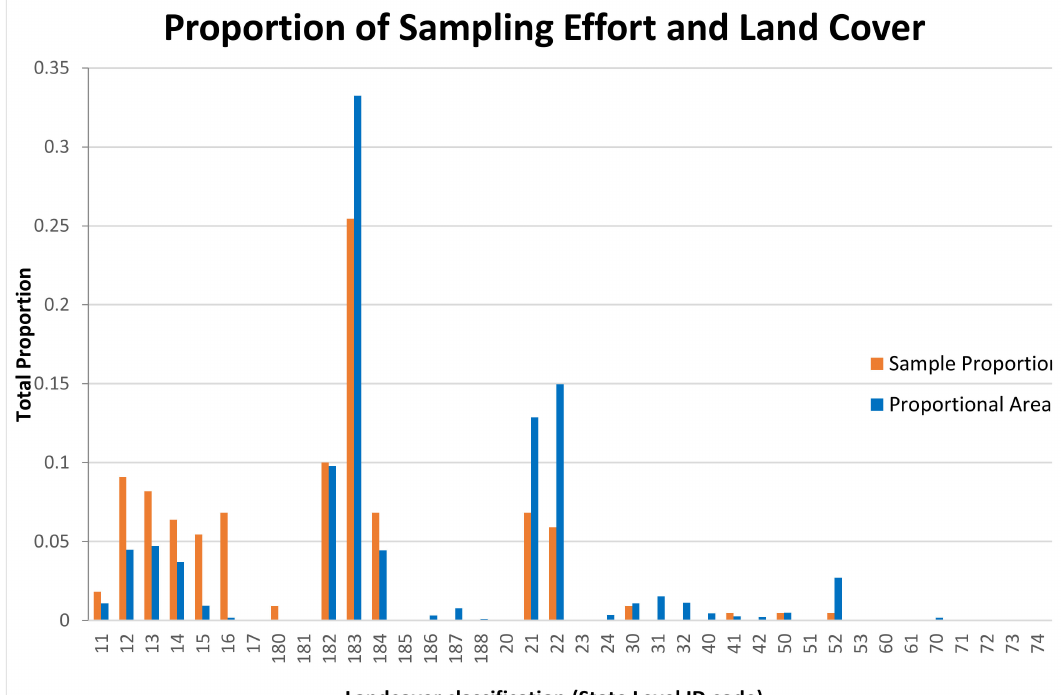
Figure 1. Proportion of transects in various landcover categories (orange) compared with geographic extent (blue) within Florida. There was no significant di ff erence in the landcover classes surveyed compared with their areal